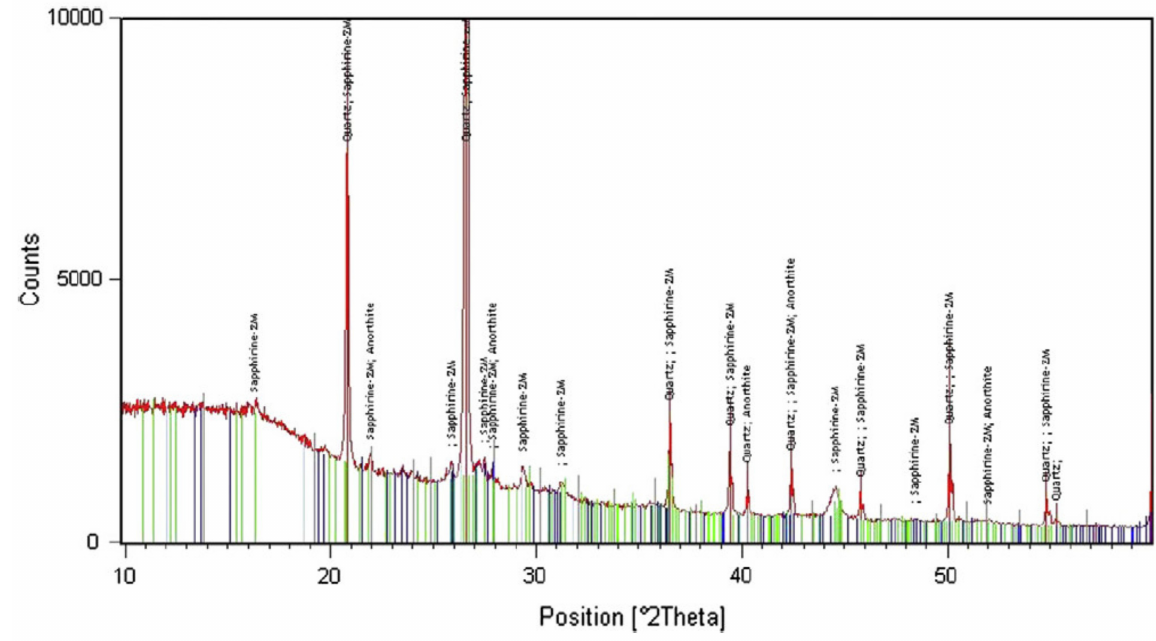
Figure 7. XRD analysis of waste wood ash (used with the permission from Elsevier [71]). WWA consists of particles sizes that vary between 10 µ m and 200 µ m, as is observed in Figure 8. The shape and size of particles vary for WWA with small particles adhering to the surface, as is observed. WWA consists of particles with an irregular shape due to the inorganic particles present in it (Etiegni and Campbell, 1991) [62].